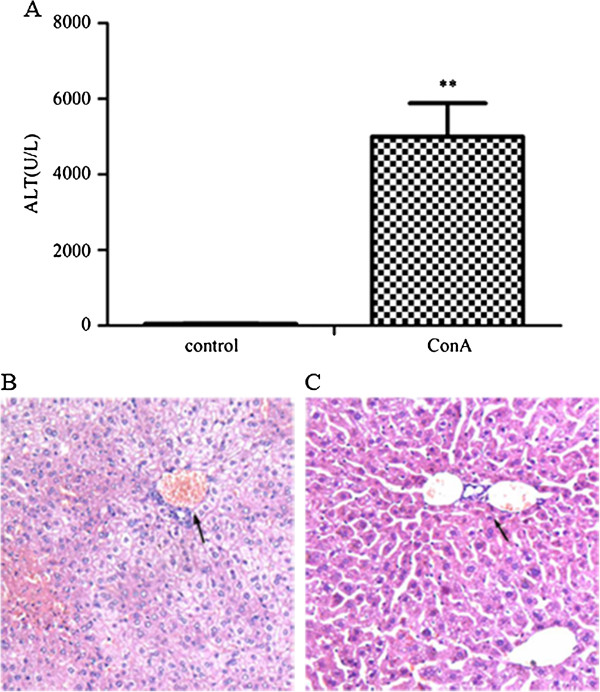
The characterization of a mouse model with autoimmune hepatitis. The serum ALT levels (A) and histological examination of liver tissues (B-C) were shown. The ALT levels were elevated in serum at 20 h after ConA treatment for BALB/c mice (n = 6, **p < 0.01). The hepatic vein showed pathological changes obviously (arrow indications) in liver biopsy of AIH mice (B), while the hepatic portal vein and hepatic lobule are clear in normal mouse liver (C).